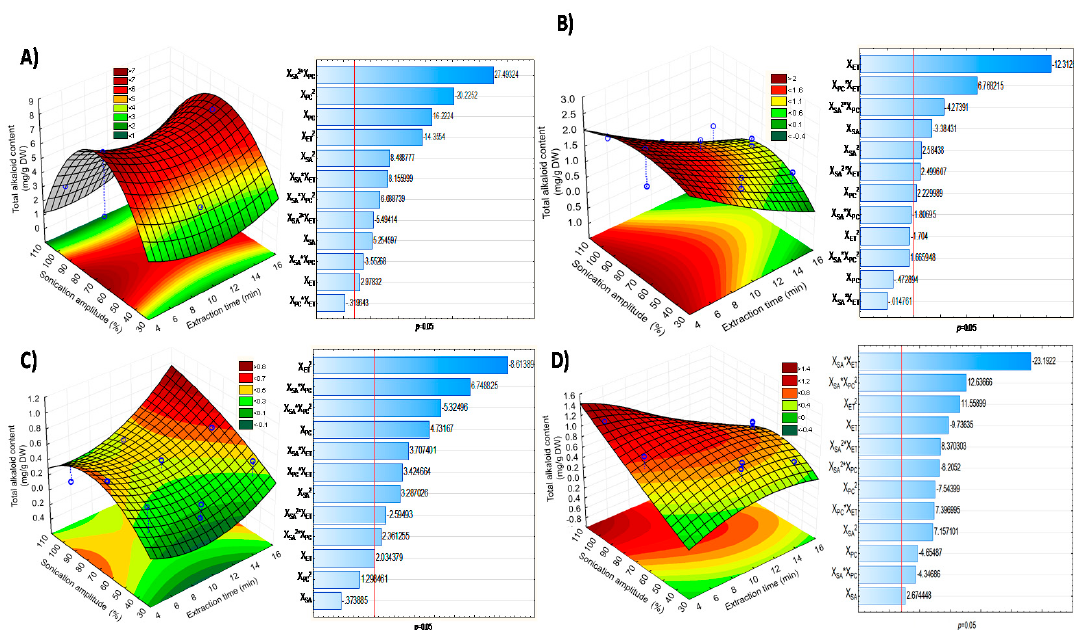
Figure 1. Response surface plots and pareto charts of total alkaloid content from A . muricata peel ( A ), seed ( B ), columella ( C ), and pulp ( D ) after the ultrasound-assisted extraction. DW = dry weight. X SA = sonication amplitude (%). X ET = extraction time (min). X PC = pulse cycle.